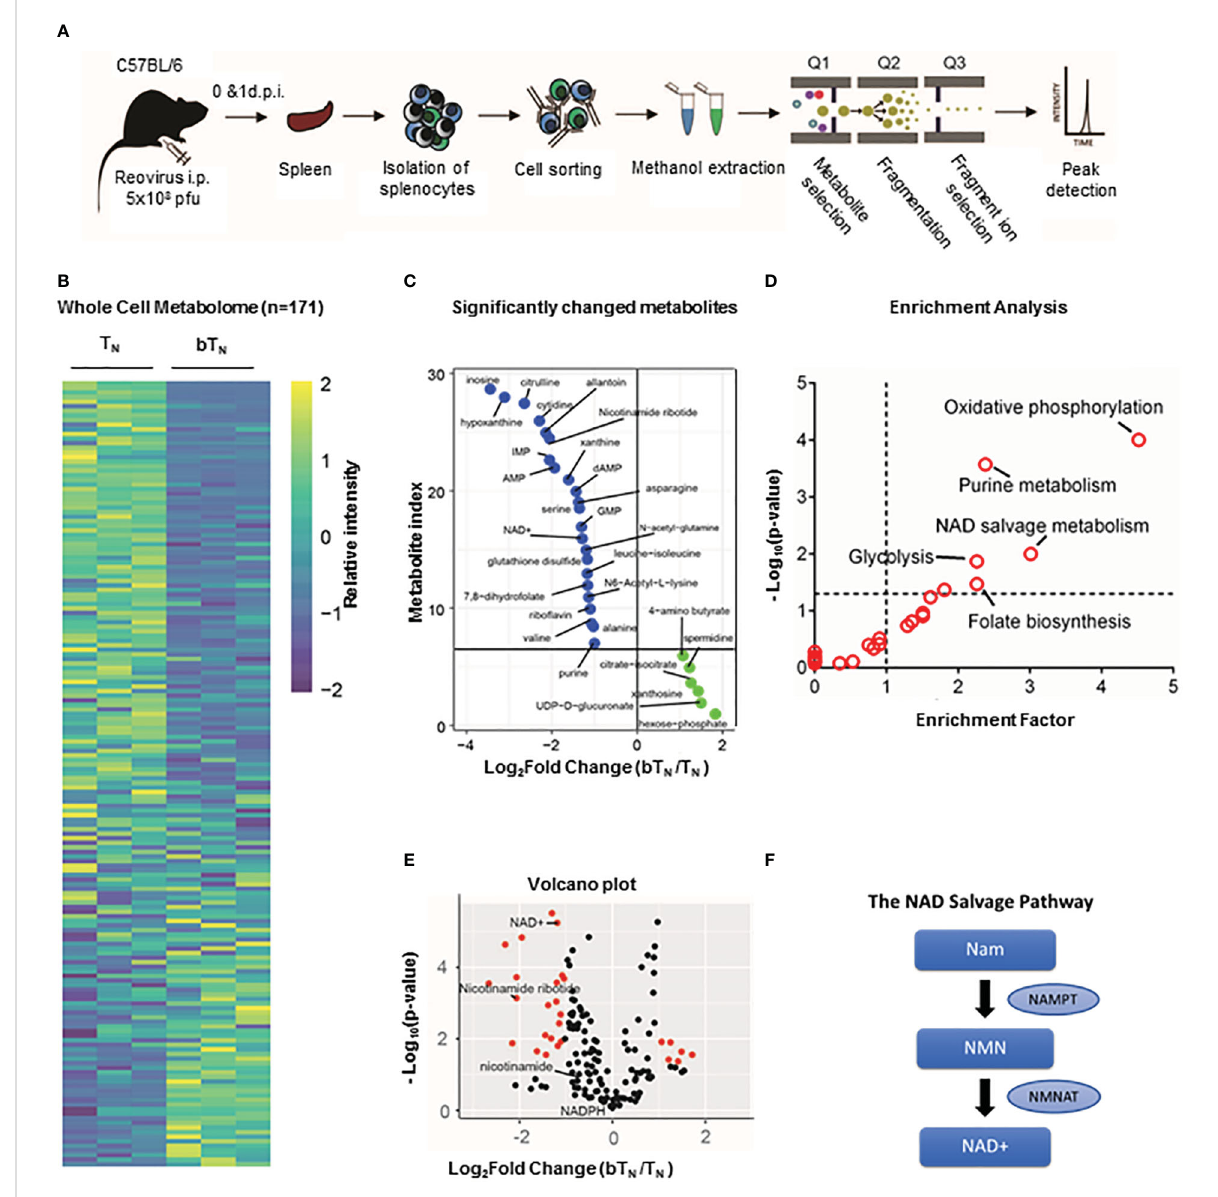
FIGURE 5 Semi-targeted metabolome analysis of CD8 bT N cells. (A) Schematic for the work fl ow of metabolome analysis of T cells. (B) Whole cell metabolome heatmap. (C) List of signi fi cant top upregulated and downregulated metabolites in CD8 bT N cells. (D) Signi fi cant metabolite Enrichment analysis of signi fi cantly changed metabolites. (E) Volcano plot depiciting metabolites that are signi fi cantly changed in CD8 bT N cells versus CD8 T N cells. NAD + salvage metabolites are highlighted in red. (F) NAD + salvage pathway. NAM- Nicotinamide, NMN- Nicotinamide mononucleotide and NAD + - Nicotinamide adenosine